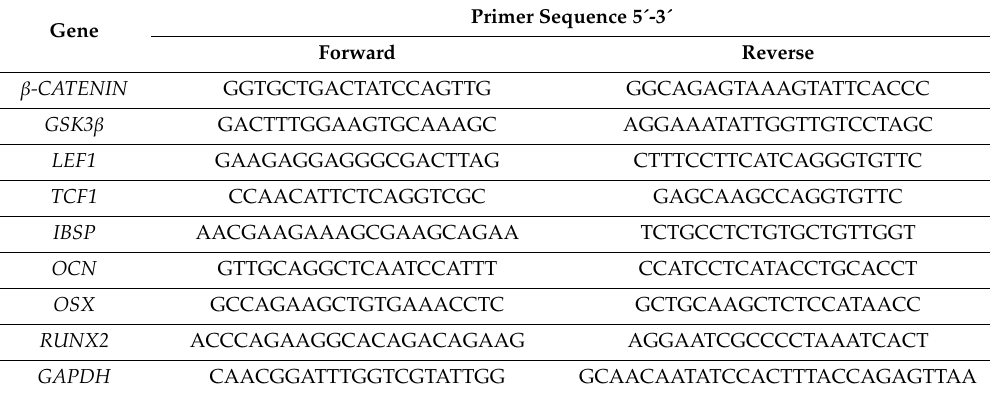
Table 1. Primers Used for